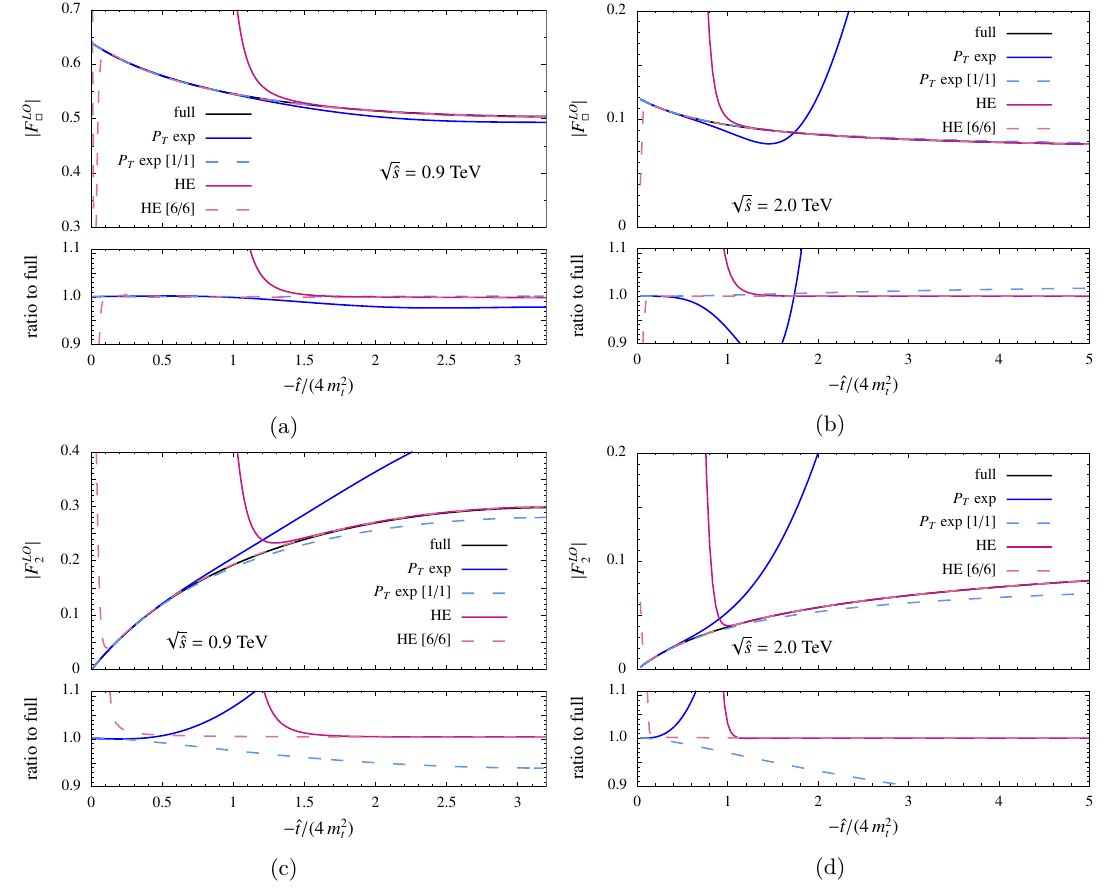
Figure 1. Modulus of the box form factors contributing to gg → HH at LO, for a fixed value of (a,c) √ √ ˆ s = 0 . 9 TeV and (b,d) ˆ s = 2 TeV. In the upper part of each plot, the exact prediction (solid black line) is shown together with the p and HE expansions (solid blue and purple lines, respectively) and T with the [1/1] p and [6/6] HE Padé approximants (dashed light blue and pink lines, respectively). T The bottom part of each plot shows the ratio of the above results to the exact